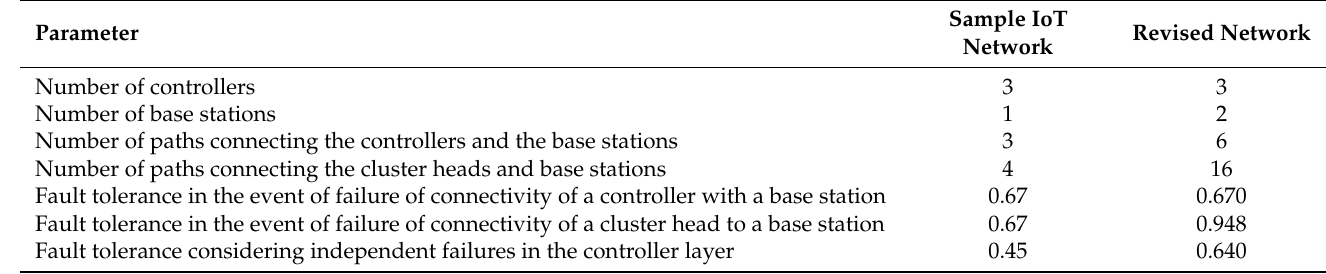
Table 7. Analysis of Failure conditions Vs. Fault tolerance level of the